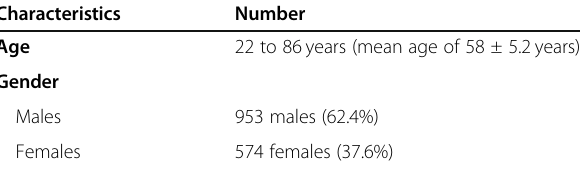
Table 1 Demographic features of the study population Characteristics